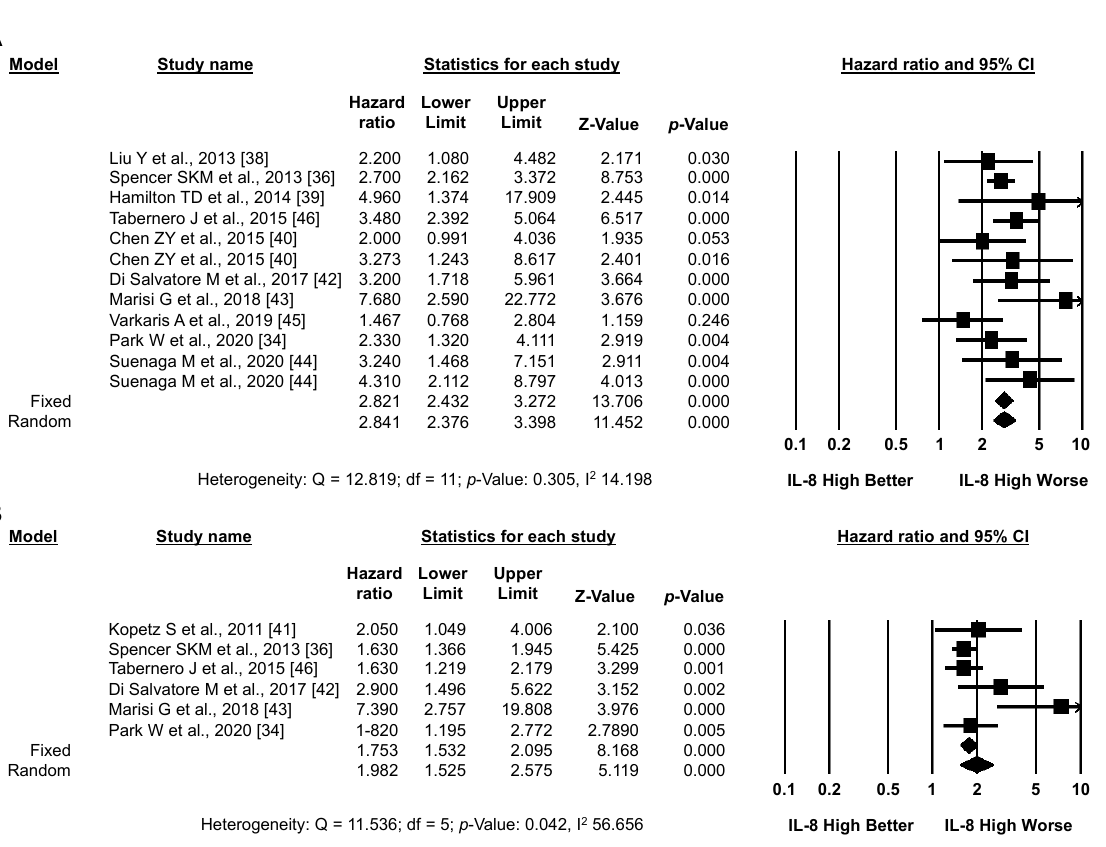
heterogeneity between studies for OS and high heterogeneity for PFS (I2: 1.718 and 55.180, respectively). Similarly, a significant negative impact of IL-8 expression on OS was observed in the five studies (735 patients) in which CRC patients received chemotherapy without anti-angiogenic agents (pooled HR by random effect model: 2.185; 95% CI: 1.571– 3.039; p < 0.001; Figure 6C), without heterogeneity (I2: 0.000). No data on PFS were available in these studies. No significant effect of IL-8 expression on either OS or PFS was observed in the two series (783 patients) that included CRC patients treated both with and without anti-angiogenic agents (Figure 7A,B) [35,36]. Figure 4. High IL-8 levels in the circulation and tissues correlates with worse PFS. Meta-analysis of the HR for the association of high levels of IL-8 and unadjusted/adjusted ( A ) or adjusted ( B ) PFS data.